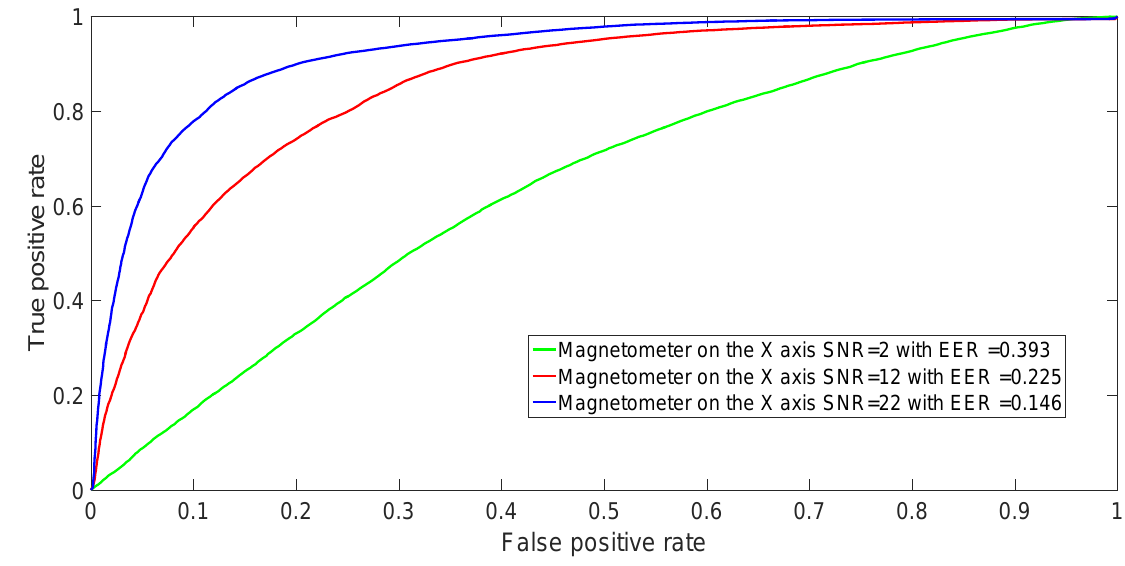
Magnetometer on the X axis SNR=2 with EER =0.393 Magnetometer on the X axis SNR=12 with EER =0.225 Magnetometer on the X axis SNR=22 with EER =0.146